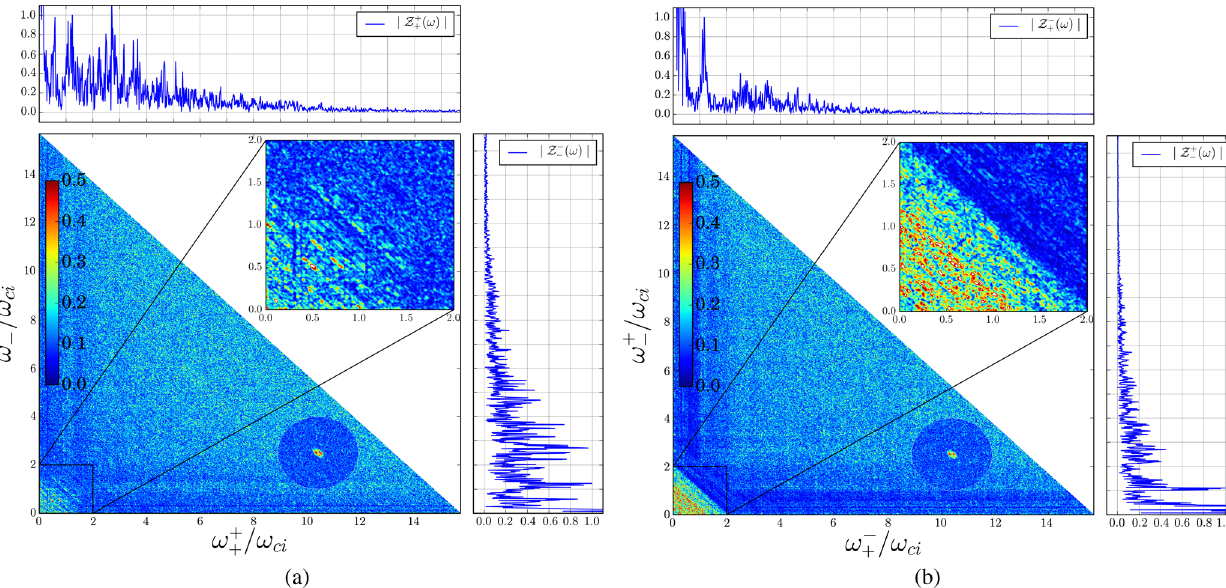
FIG. 9. (a) Cross-bicoherence C RR resulting from the coupling between three whistler waves, two of which have opposite polarity. (b) Cross-bicoherence C LL resulting from the coupling between three ion-cyclotron waves, two of which have opposite polarity. For convenience, the norm of the time Fourier transform of the generalized Elsässer fields normalized by their respective maximum value around ω ci ¼ 1 are also shown above and beside each plot. The intense signal surrounded by a circle of weaker signal corresponds to the fiducial bicoherence mentioned in the text. This gives an idea of the statistical noise inherent to the statistical ensemble that we consider, as well as the signature of quadratically phase-coupled waves.